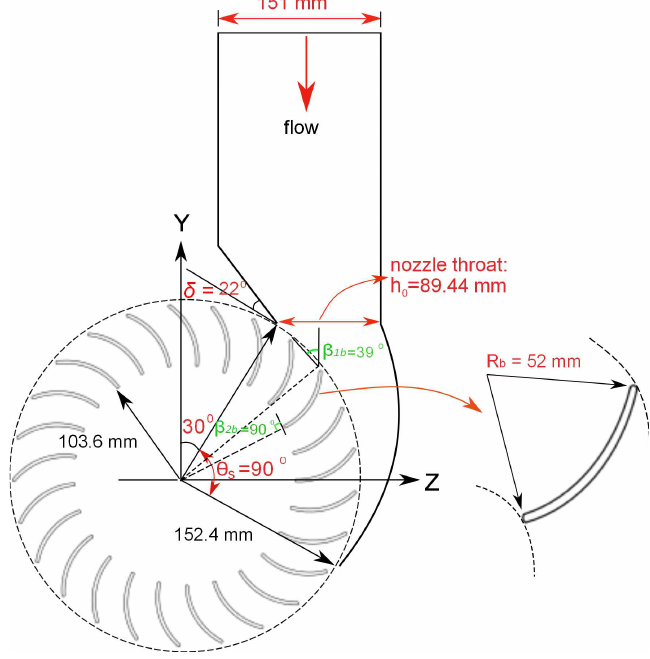
Figure 5. Schematic illustration of the 0.53 kW turbine [19] with η max = 88% [5]. Table 2. Design parameters of 7 kW and 0.53 kW [19] turbines studied by [2] and [5]. β 1 is evaluated at ω max from Equation